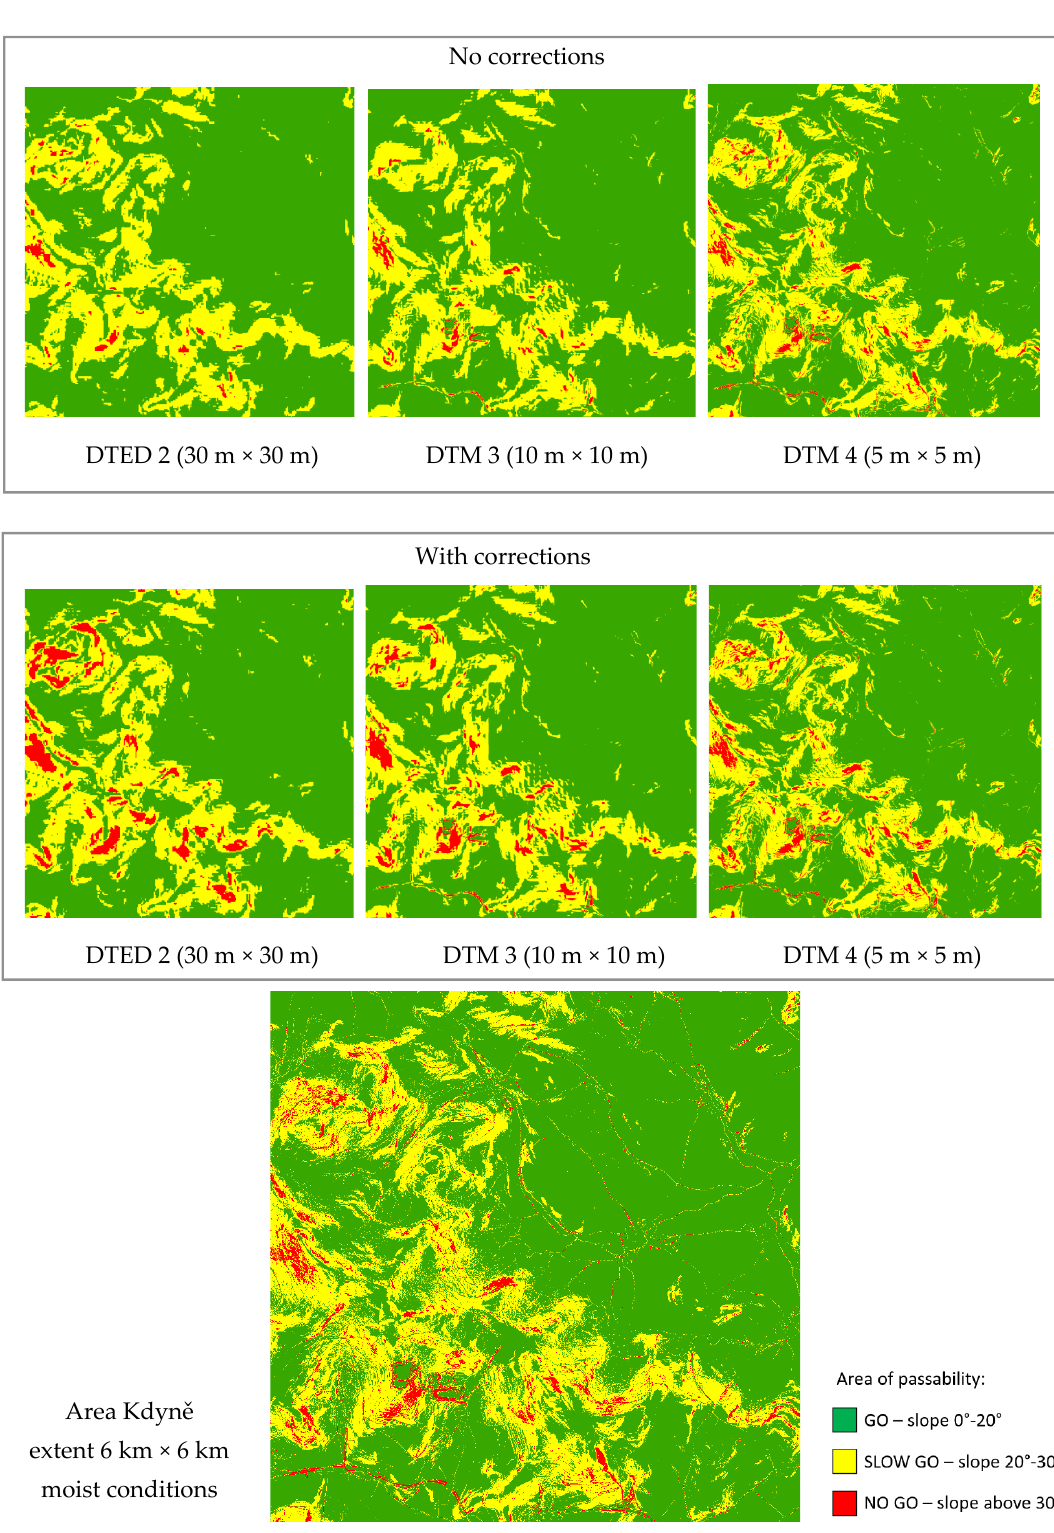
Figure 9. The map comparison of the CCM analysis with different elevation models (DTM 5, DTM 4, DTM 3, DTED 2) without slope corrections and with slope corrections. The slope corrections en- abled accurate results of CCM analysis for lower-detail models. DTM 5 (1 m × 1 m) served as the reference model.